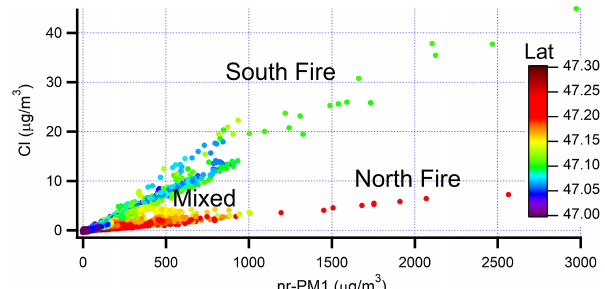
Figure 6. Cl concentration as a function of nr-PM1 for flight 730b. Data points are at 1Hz. Spatial locations of North and South fires shown in Fig. 3.